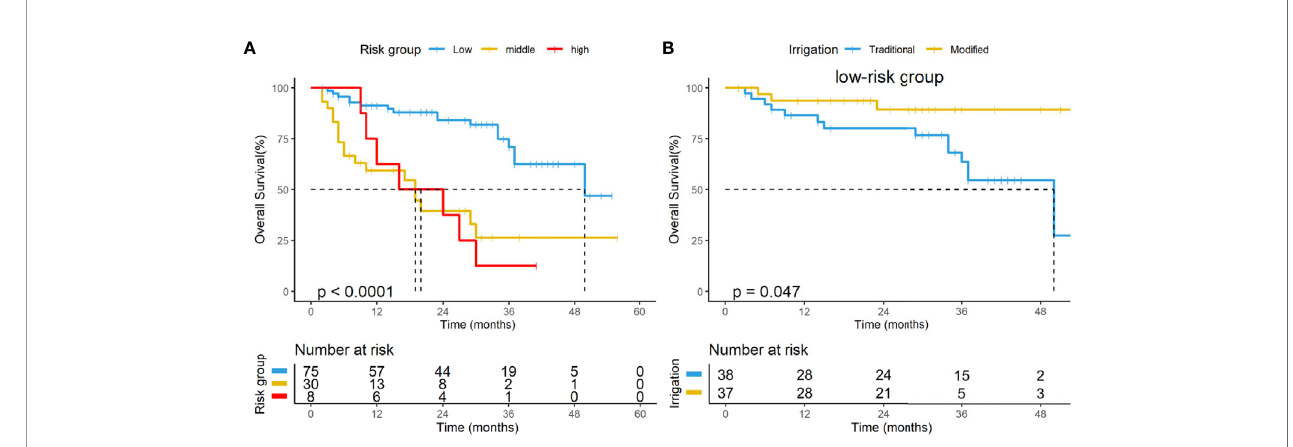
FIGURE 5 | (A) Kaplan – Meier curves of overall survival for all patients in the subgroups based on the new risk classi fi cation system. (B) Subgroup analysis for patients in the low-risk group based on the new risk classi fi cation